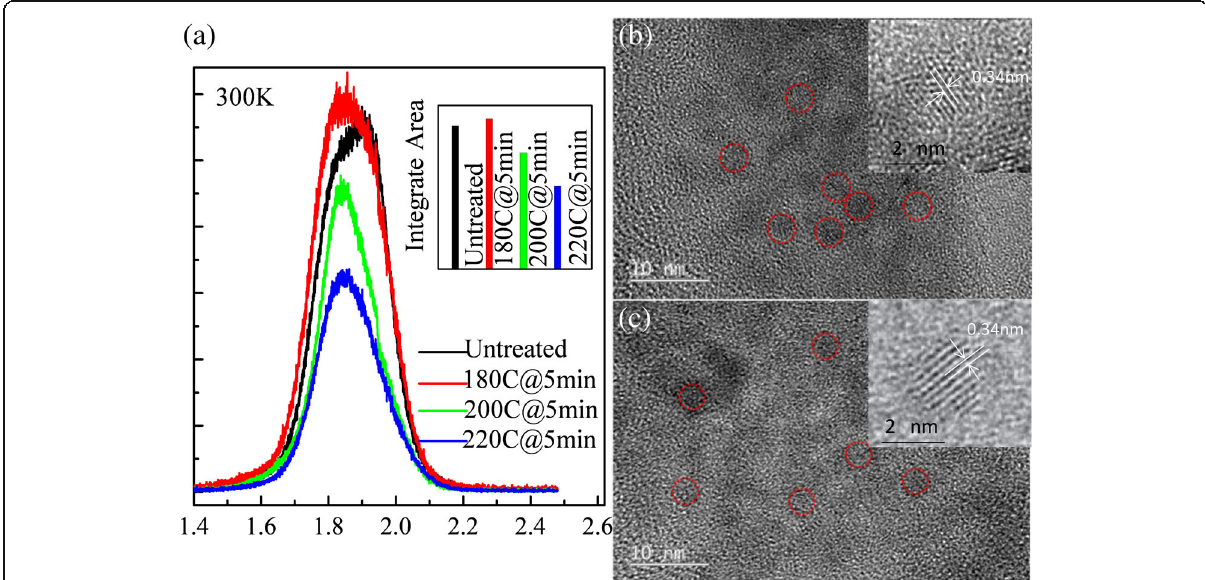
Fig. 3 a PL spectra of the InP/ZnS QD film (black line) and after annealing at 180 °C (red line), 200 °C (blue line), and 220 °C (cyan line) for 5 min at room temperature. Insert picture shows the integrated intensities of the PL spectra for different samples. The transmission electron microscopy (TEM) images of the untreated sample ( b ) and sample annealed at 180 °C for 5 min ( c